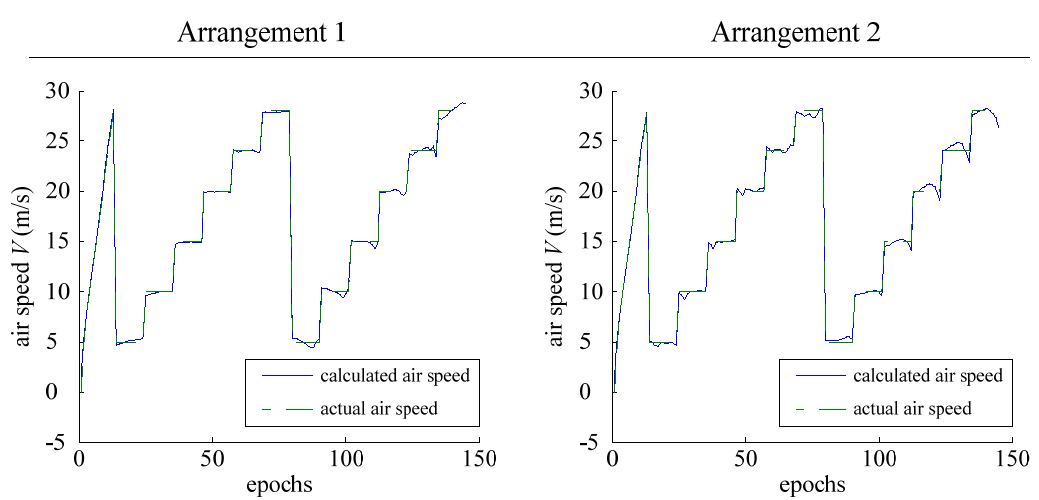
Figure 7. Setup of wind tunnel experiment.